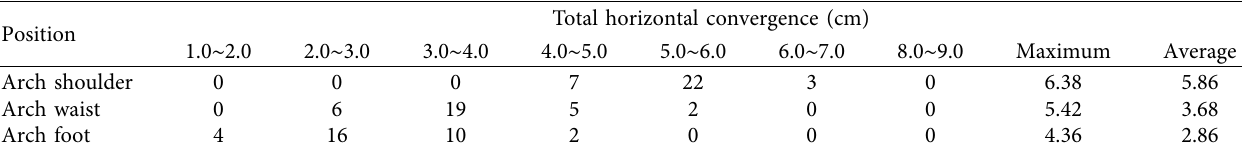
Table 5: Statistics of total horizontal convergence (32